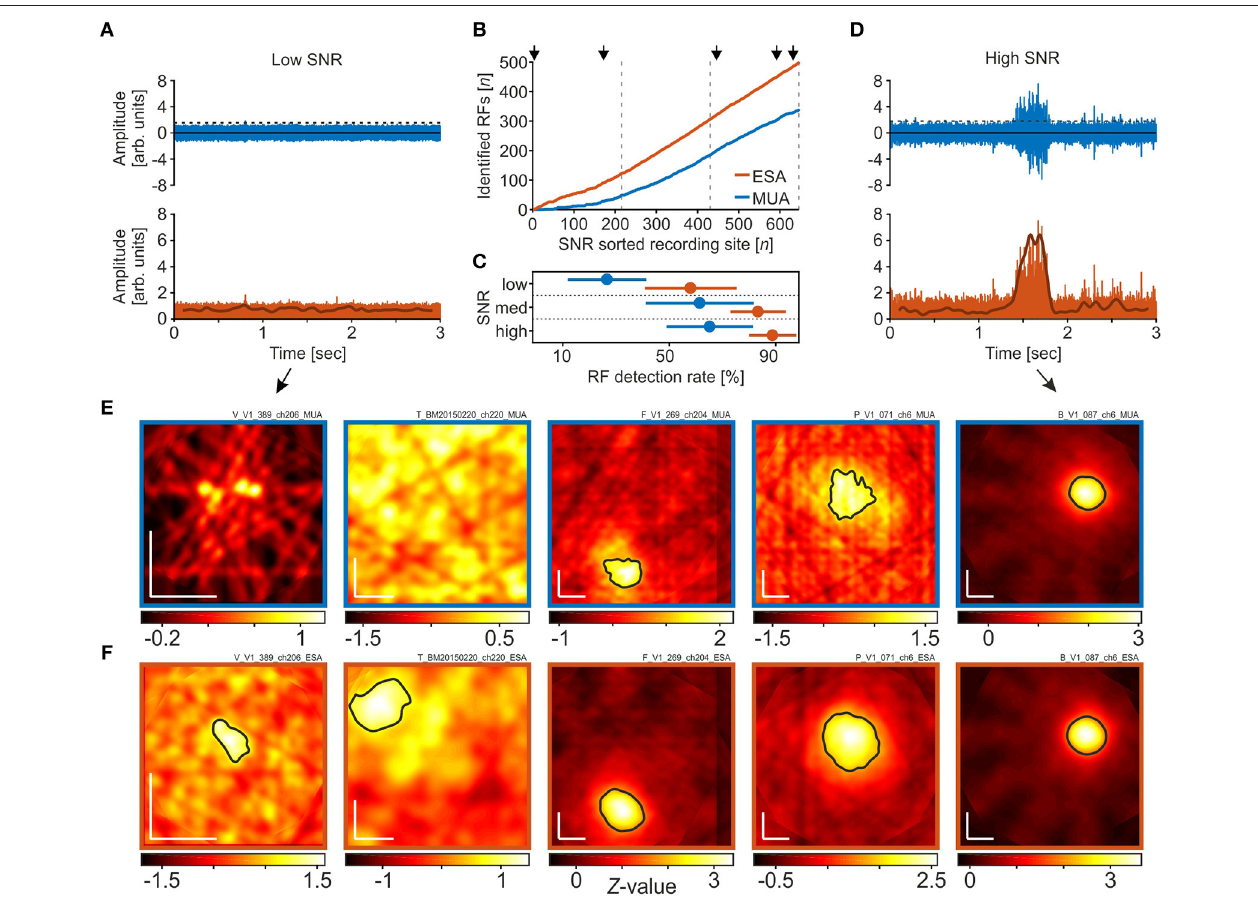
FIGURE 3 | RF detection rates in dependence of signal-to-noise ratio (SNR). (A) High-pass filtered neuronal activity with very poor SNR (rank 4 out of 653). The upper panel depicts a single trial in response to a motion direction that reliably modulated the LFP. The dashed line indicates the threshold as calculated over all trials, using the method of Quiroga et al. (2004) with a median multiplication factor of a 2. Events surpassing the threshold are used to calculate the spike density function. The = lower panel shows the same high-passed signal after full-wave rectification. Subsequent low-pass filtering provides the ESA-signal (thick line), revealing a small amplitude modulation during the course of the trial. (B) Cumulative distribution of the number of RFs detected using either MUA or ESA, sorted by SNR. Dashed lines distinguish equally large fractions of recording sites with low, medium, and high SNR, as used for statistical analysis. Arrows indicate the SNR ranks of the five example sites shown in (E,F) . (C) Detection rates for low, medium, and high SNR sites, based on the respective detection rates of data from the individual animals, separately for ESA and MUA. Disks and lines indicate mean S.D, respectively. (D) Same as in (A) , for a recording site with high SNR (rank 632). (E,F) Visual ± response maps based on thresholded MUA (E) and ESA (F) for the five recording sites indicated in (B) . SNR rank increases from left to right. Vertical and horizontal white bars in the lower left corners indicate 1 ◦ of visual space. Black outlined areas depict significant visual responses (receptive fields). For the two left-most maps in (E) no significant visual response was found with any of the thresholds tested during the iterative procedure. Actual maps were calculated based on a median multiplication factor of a 2 for setting the threshold. Remaining maps (middle to right) were calculated after thresholding with a 3. = =